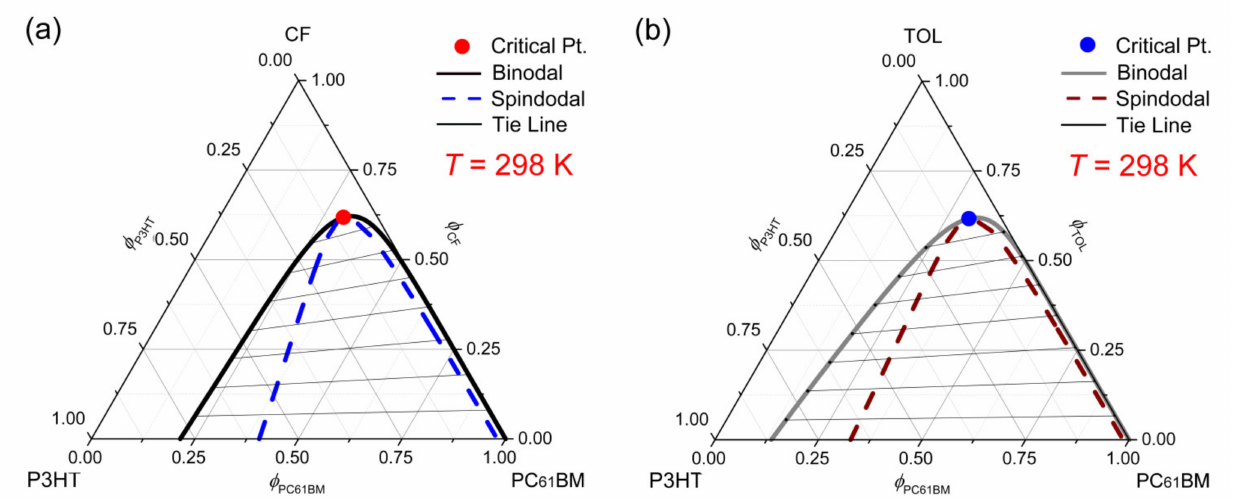
Figure 5. Phase diagrams for the ternary system at constant T = 298 K. ( a ) CF/P3HT/PC 61 BM: χ 12 = 0.37, χ 13 = 0.95, χ 23 = 0.92, s = 0.004006 and r = 0.131993. ( b ) TOL/P3HT/PC 61 BM: χ 12 = 0.35, χ 13 = 1.37, χ 23 = 1.55, s = 0.005296 and r = 0.174481. Here, CF and TOL represent chloroform and toluene, respectively.